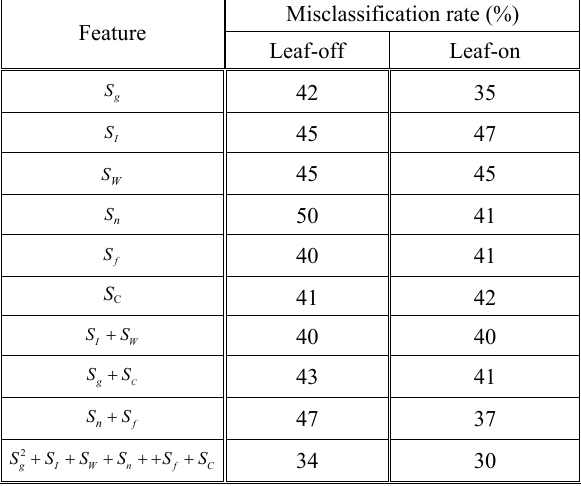
Table 6 5-fold cross-validation results of SVM classification of dead and living trees using different combinations of tree segment features, the misclassification rate measures the proportion of misclassified observations of both classes.